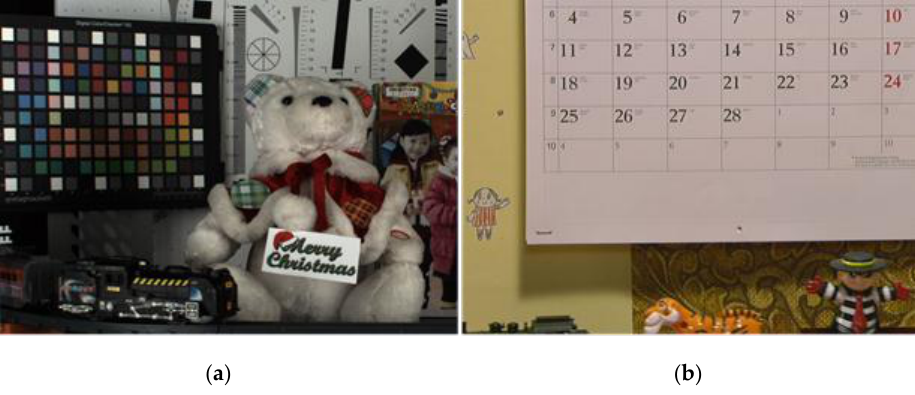
Figure 9. Scenes of two video sequence. ( a ) The Moving train sequence acquired by a CFA sensor; ( b ) The Calendar sequence.